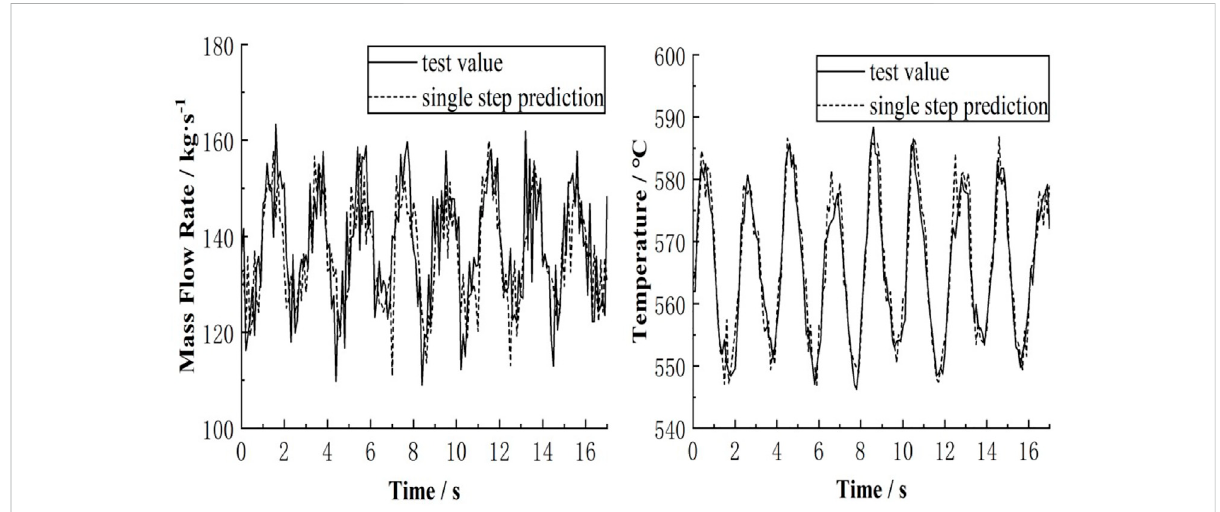
FIGURE 9 Contrast between the test samples and single-step forecasting results.